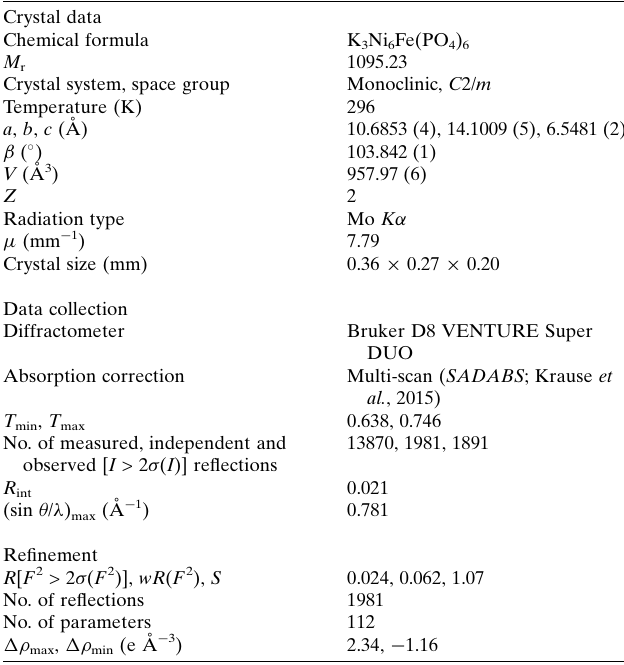
Table 1 Experimental details. Crystal data Chemical